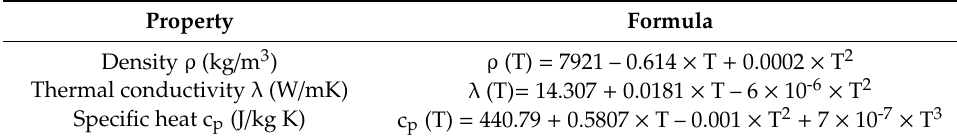
Table 4. Thermo-physical properties of the stainless steel 316L [31].